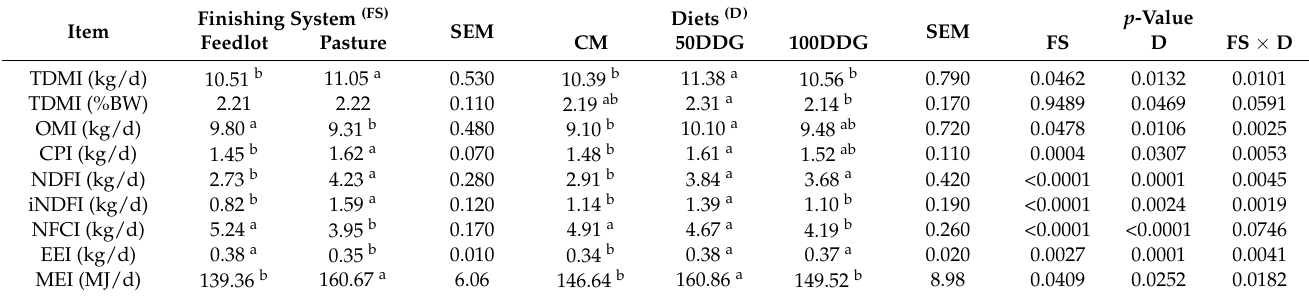
Table 4. Nutrients intake of cattle in pasture and feedlot finishing